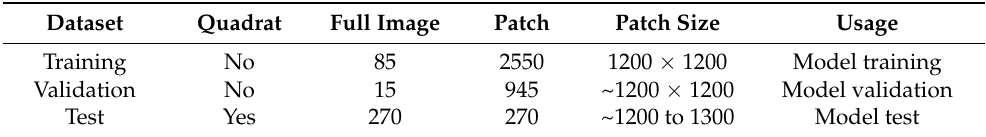
Table 1. A brief introduction of UAV datasets used in this